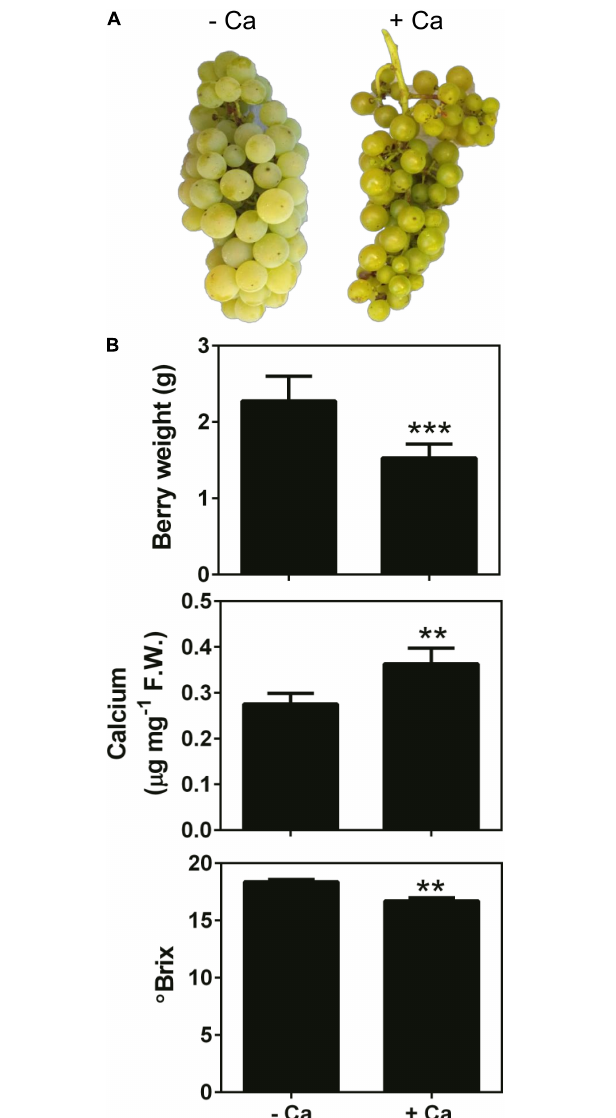
FIGURE 1 | Appearance (A) , weight, Ca content, and ◦ Brix (B) of mature berries from vines cv. Loureiro treated with Ca (+ Ca) or without treatment (– Ca). Images in panel (A) are representative of two consecutive seasons. Results are expressed as mean ± SD and asterisks denote statistical significance as compared to control (– Ca): ** P ≤ 0.01; *** P ≤ 0.001; n =